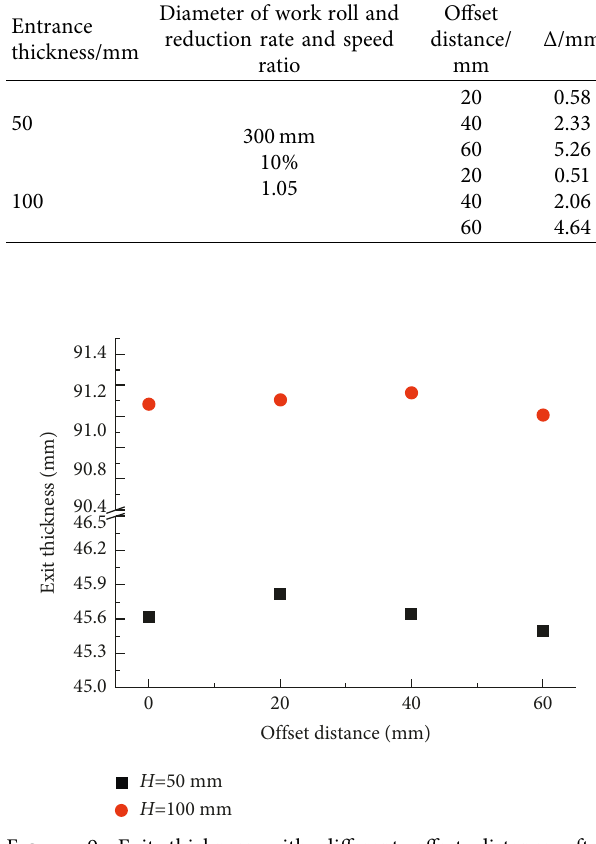
Figure 9: Exit thickness with different offset distance after